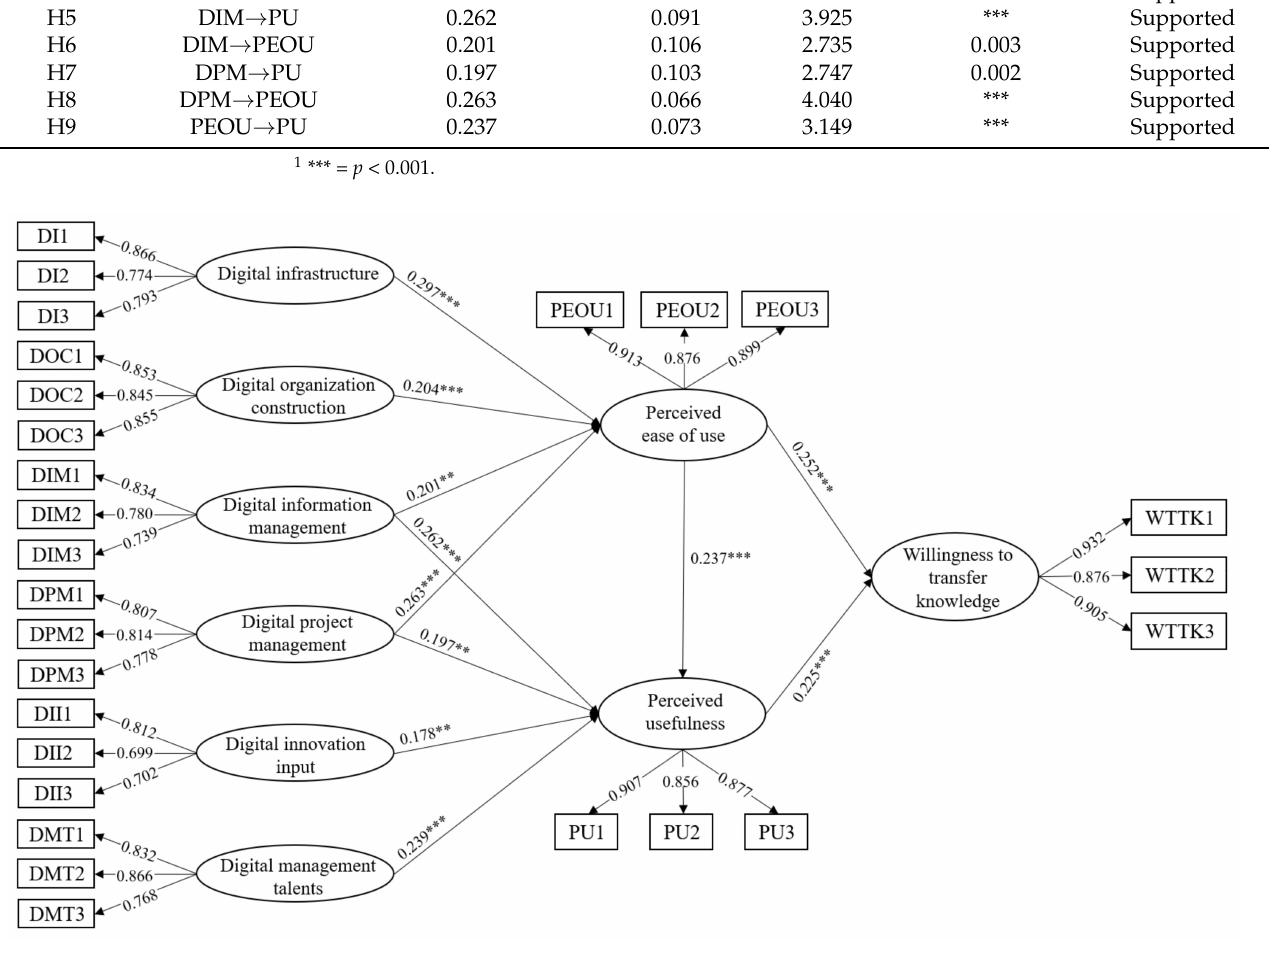
Figure 4. Projects Results of SEM Analysis. ** = p < 0.01; *** = p <